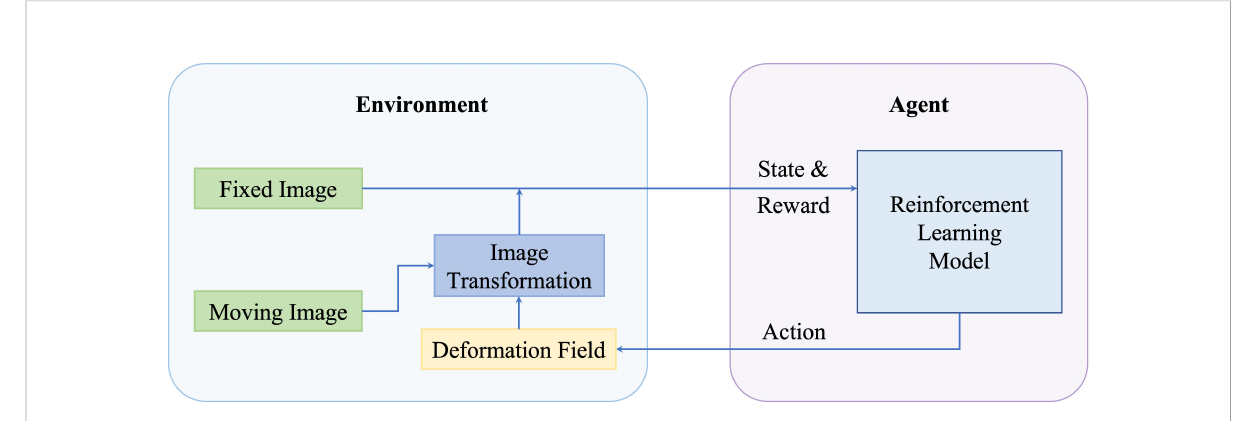
FIGURE 4 A general pipeline of deep reinforcement learning based deformable image registration methods.